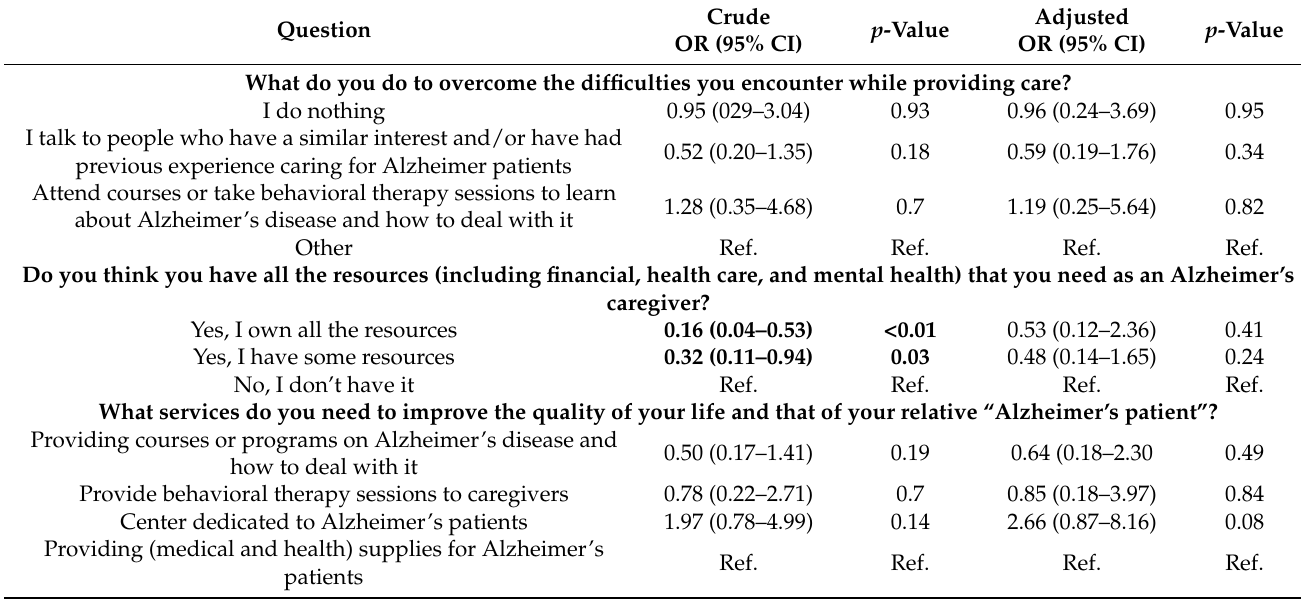
Table 5. Association of the Burden with the Coping Strategies